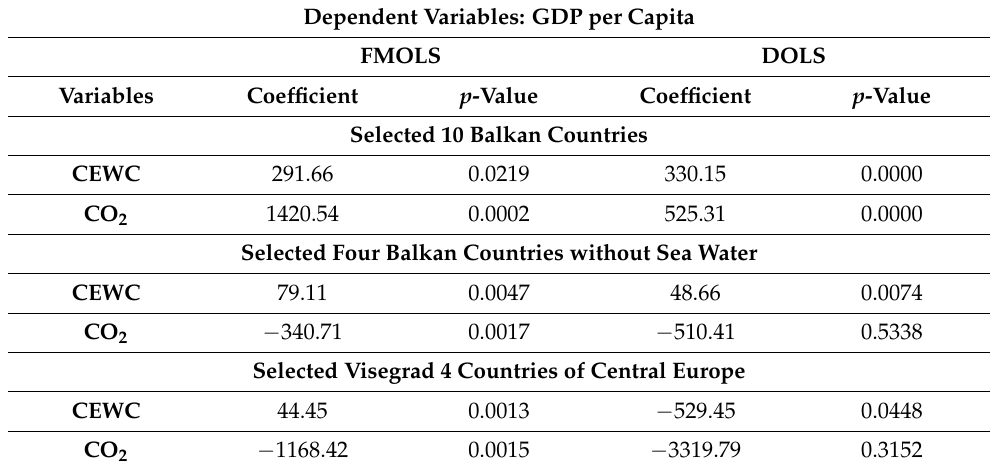
Table 5. Fully modified ordinary least squares (FMOLS) and Dynamic Ordinary Least Squares (DOLS).